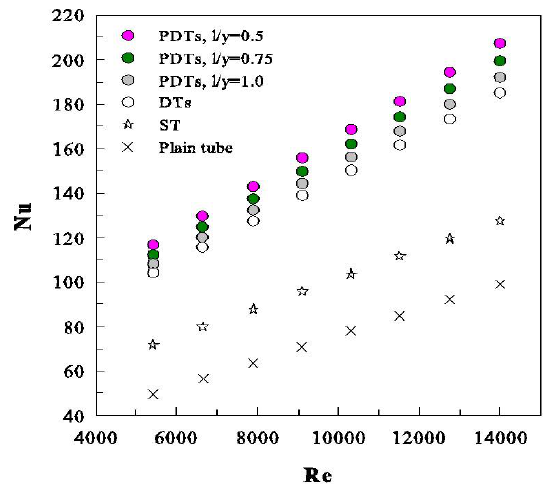
Figure 4: Nusselt number against Reynolds number for PDTs at various cutting pitch ratios ( l / y = 0.5 , 0.75 and 1.0).